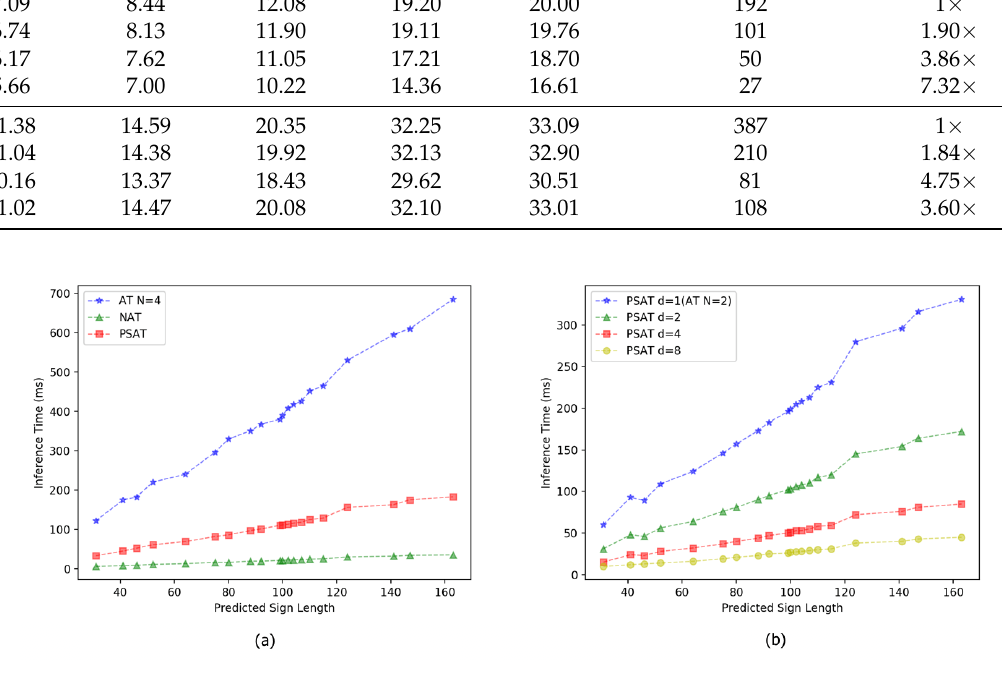
Figure 4. The relationship between inference latency and the predicted sign length in different model configurations. 20 sign poses sequence of length within [31, 163] are randomly selected. ( a )